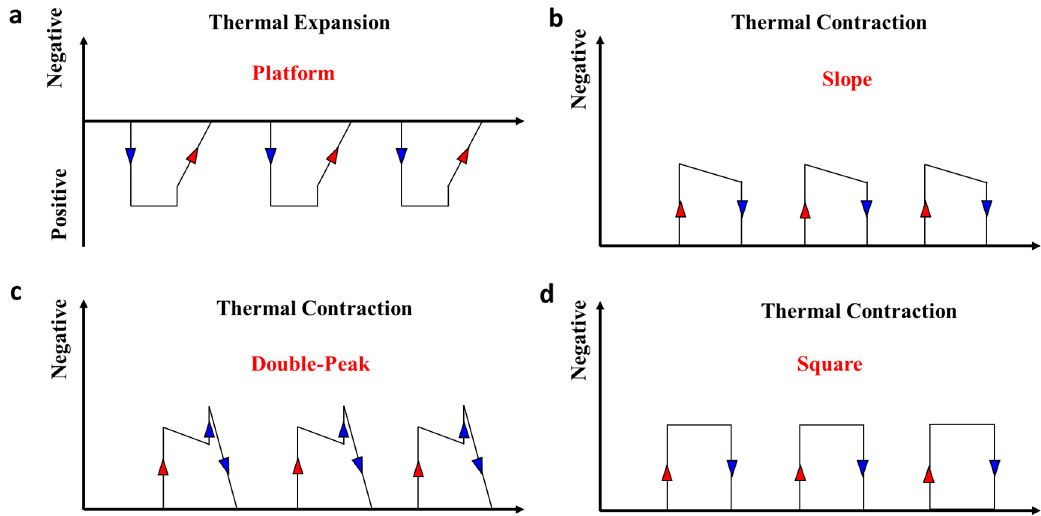
Figure 5. Multi-modal contractive forces of the wool, wool yarn, and wool yarn/polymeric yarn blends. ( a ) Platform-like stress–stroke mode originated from raw wools in the parallel structure. ( b ) Slope-like stress–stroke mode originated from two-ply wool yarn. ( c ) Double-peak stress–stroke mode originated from raw wools in the twisted structure and four-ply wool yarns. ( d ) Square stress–stroke mode originated from four-ply wool yarn/polymeric yarn blends.